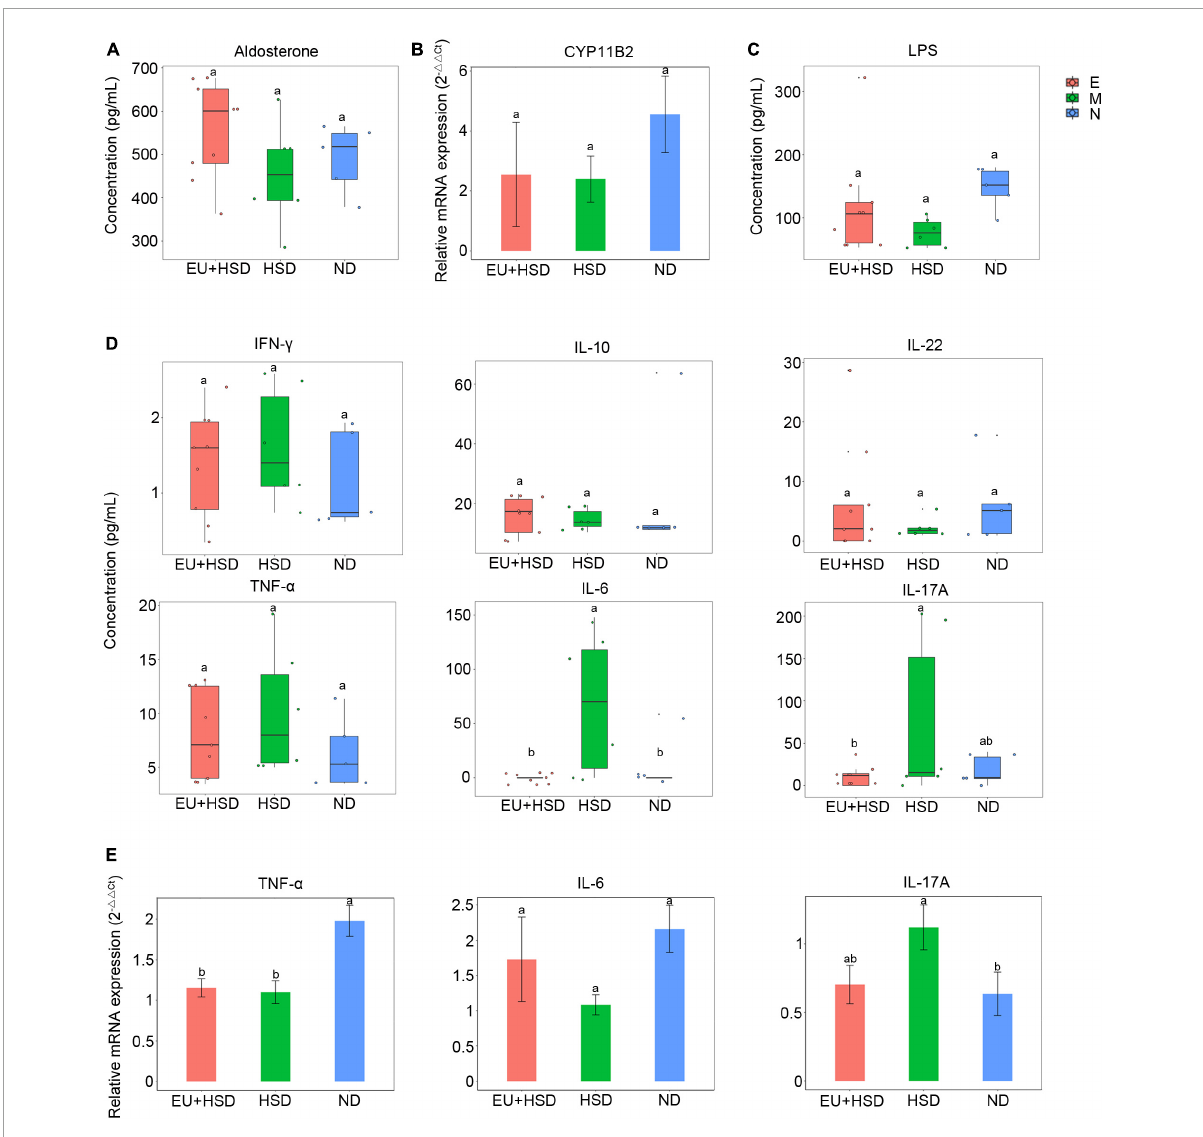
FIGURE2 Aldosterone, CYP11B2, LPS, and inflammatory cytokine profiles in week 13 after administration of EU. (A) Serum aldosterone. (B) Relative expression of renal CYP11B2 mRNA. (C) Serum LPS. (D) Serum IFN- γ , IL-10, IL-22, TNF- α , IL-6, and IL-17A. (E) Relative expression of renal TNF- α , IL-6, and IL-17A mRNA. Values are shown as mean ± standard error of the mean